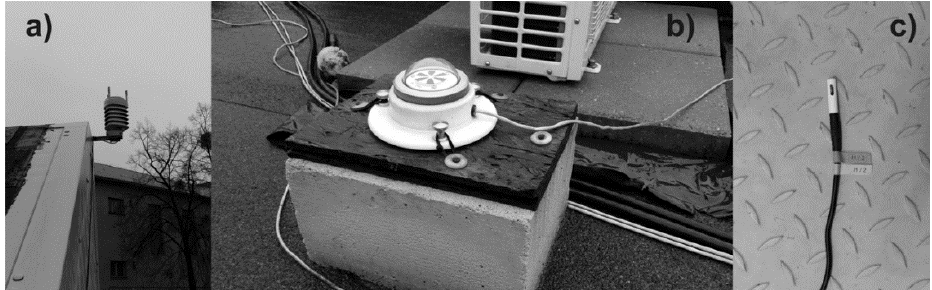
Figure 1. Measuring equipment, instruments for measuring environmental values: ( a ) weather station; ( b ) pyranometer; and ( c ) temperature sensor and relative humidity of the air [28,29].